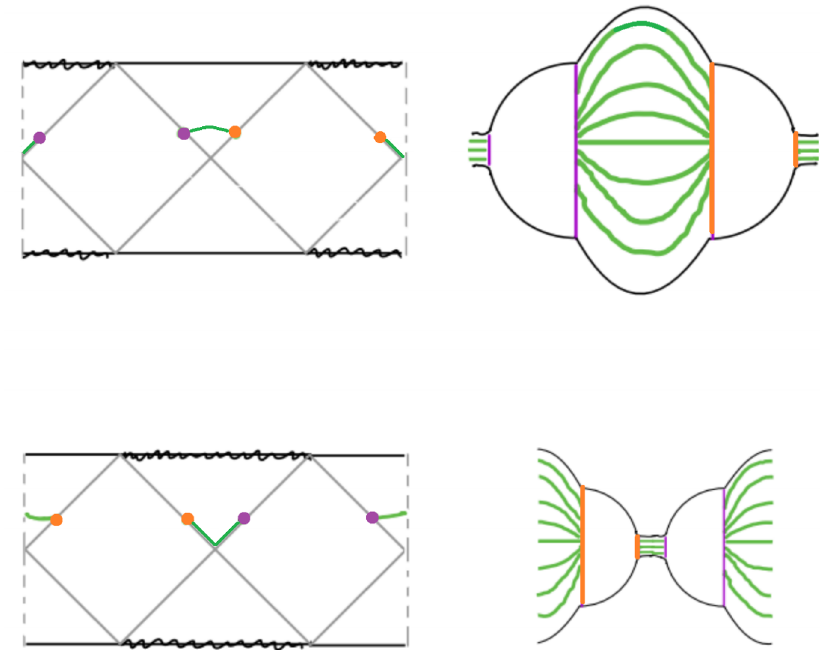
Figure 7 . The Schwarzschild-de Sitter geometry shown with bit-threads connecting the two gen- eralized horizons. The diagrams are periodically identified at the dashed vertical lines. The upper and lower panels are identical in content but are identified on different vertical